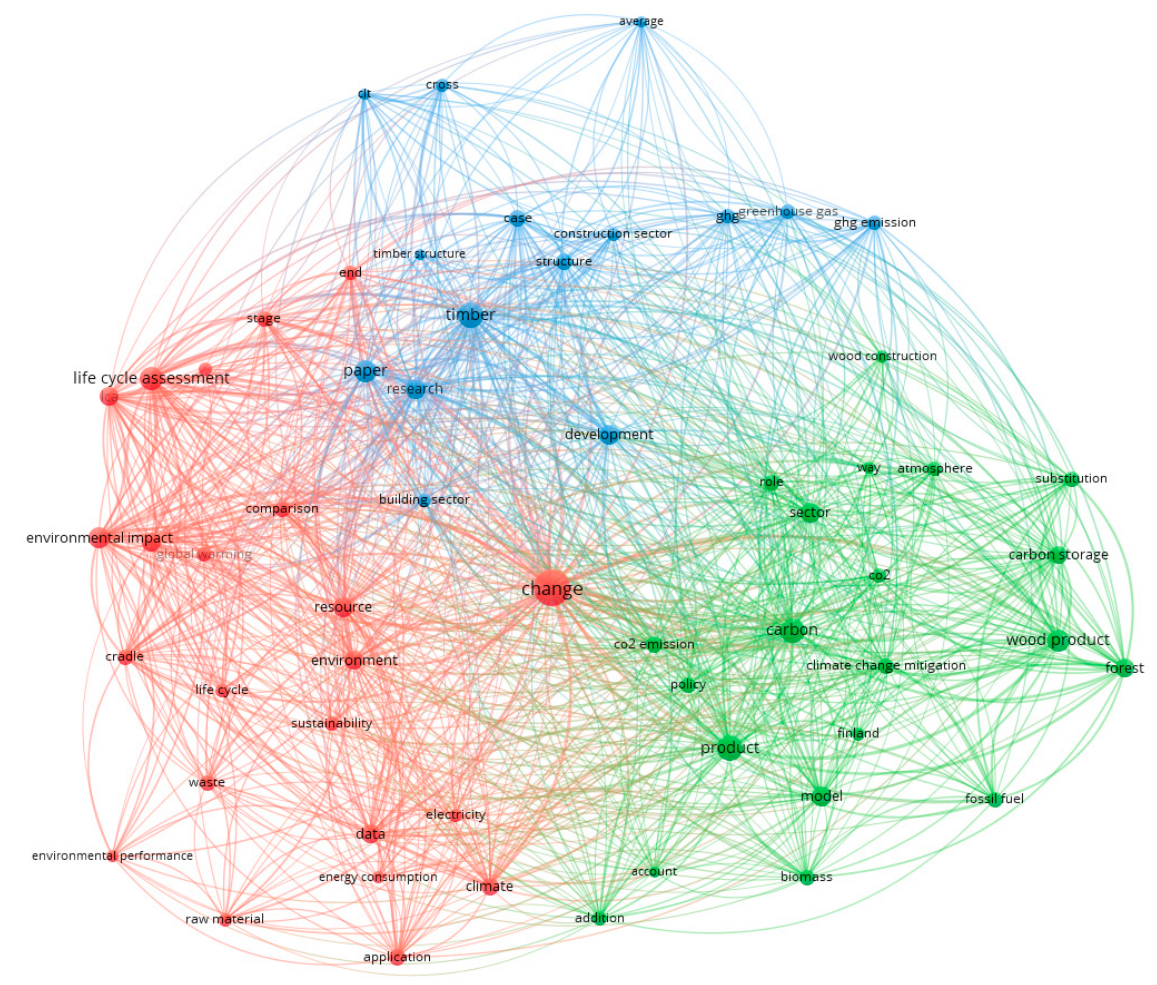
Figure 5. Highly used keywords.